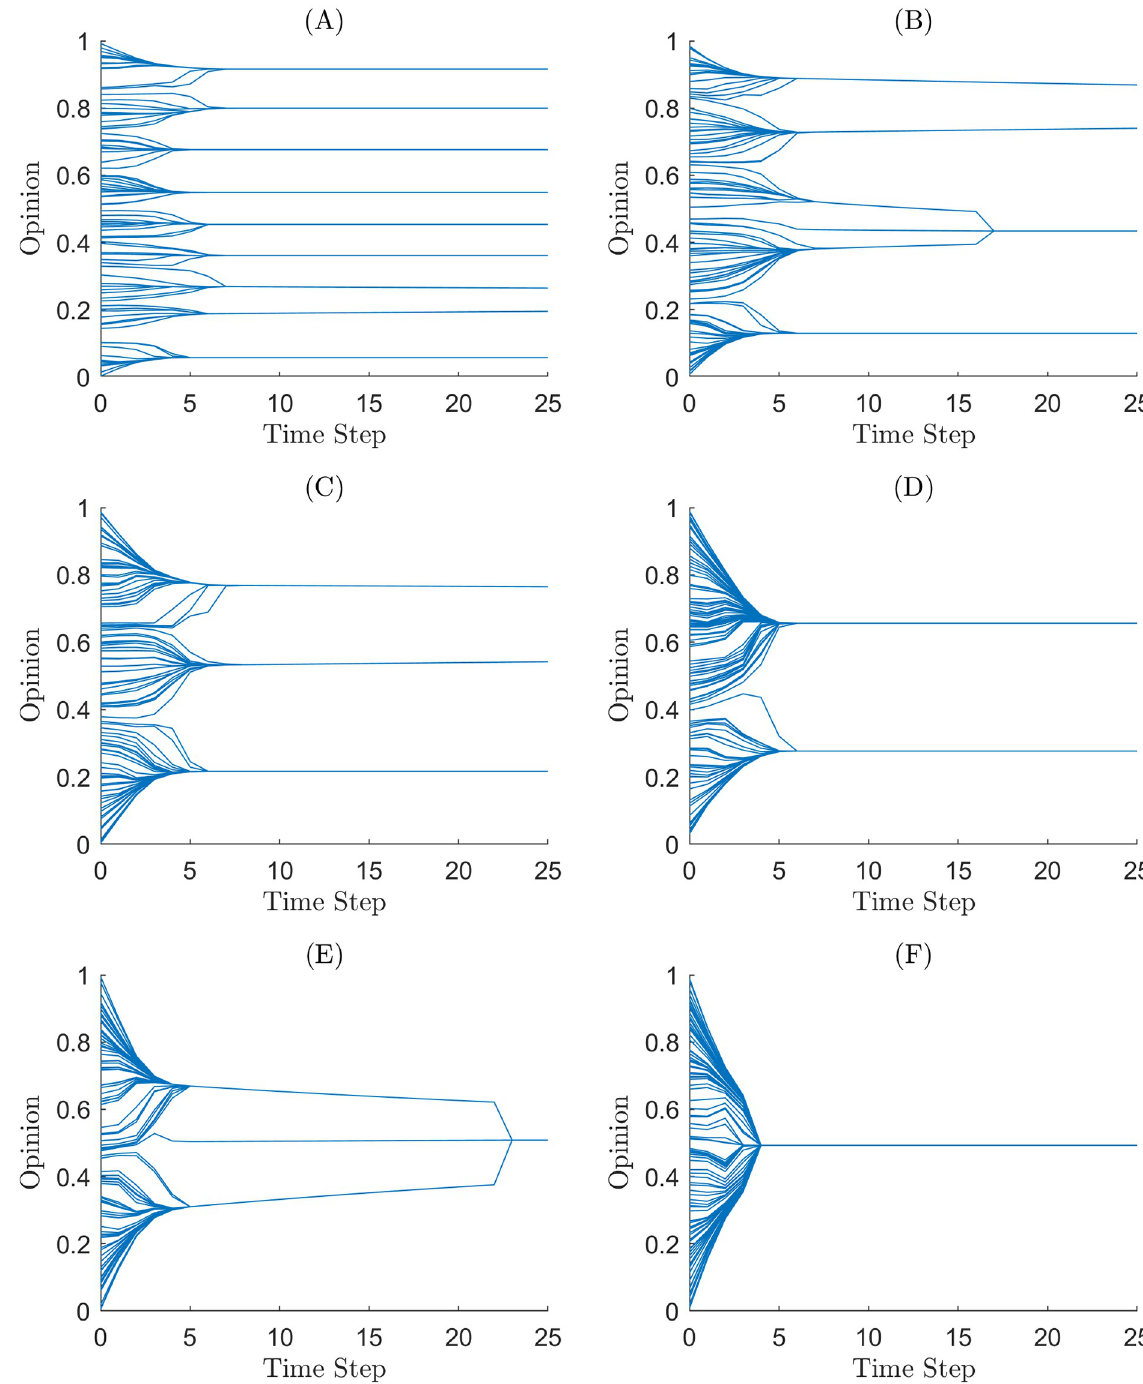
Fig 1. Sample simulations’ opinion shifts of agents through time for the HK bounded confidence model under different values of � . (A) A simulation with � = 0.05. (B) A simulation with � = 0.1. (C) A simulation with � = 0.15. (D) A simulation with � = 0.2. (E) A simulation with � = 0.25. (F) A simulation with � =